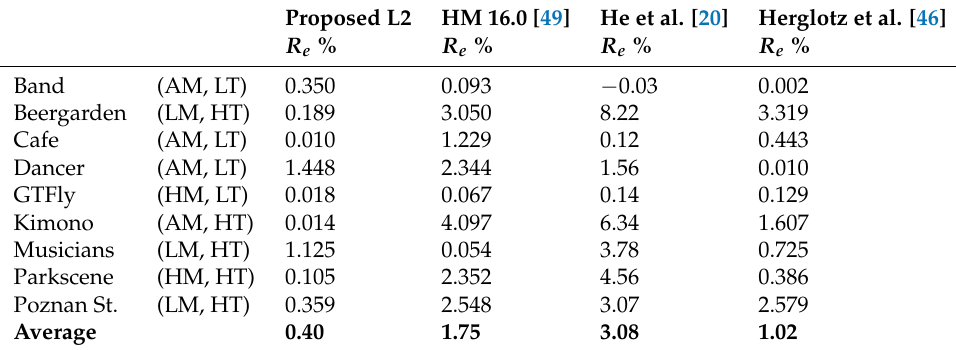
Table 1. Rate controlling performances of the encoding